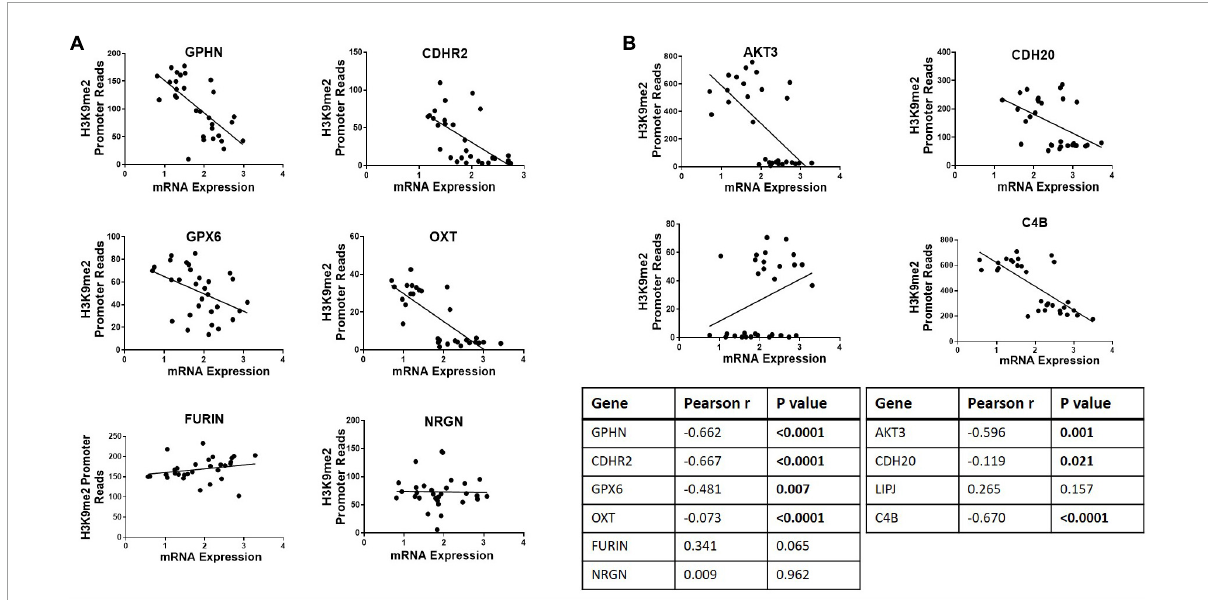
FIGURE2 Correlational analysis of H3K9me2 promoter occupation and mRNA expression. Scatterplots showing correlations between H3K9me2 promoter DiffReps reads and mRNA levels of the corresponding gene. (A) Promoter loci where H3K9me2 occupancy is significantly increased in SCZ compared to NPC. Promoters GPHN, CDHR2, GPX6, and OXT show H3K9me2 diffReps reads have significant negative correlation with their corresponding mRNA levels. (B) Promoter loci where H3K9me2 occupancy is significantly decreased in SCZ compared to NPC. Promoters AKT3, CDH20, and C4B show H3K9me2 diffReps reads have significant negative correlation with their corresponding mRNA levels. Pearson’s r and P -values for each loci are shown in the insert